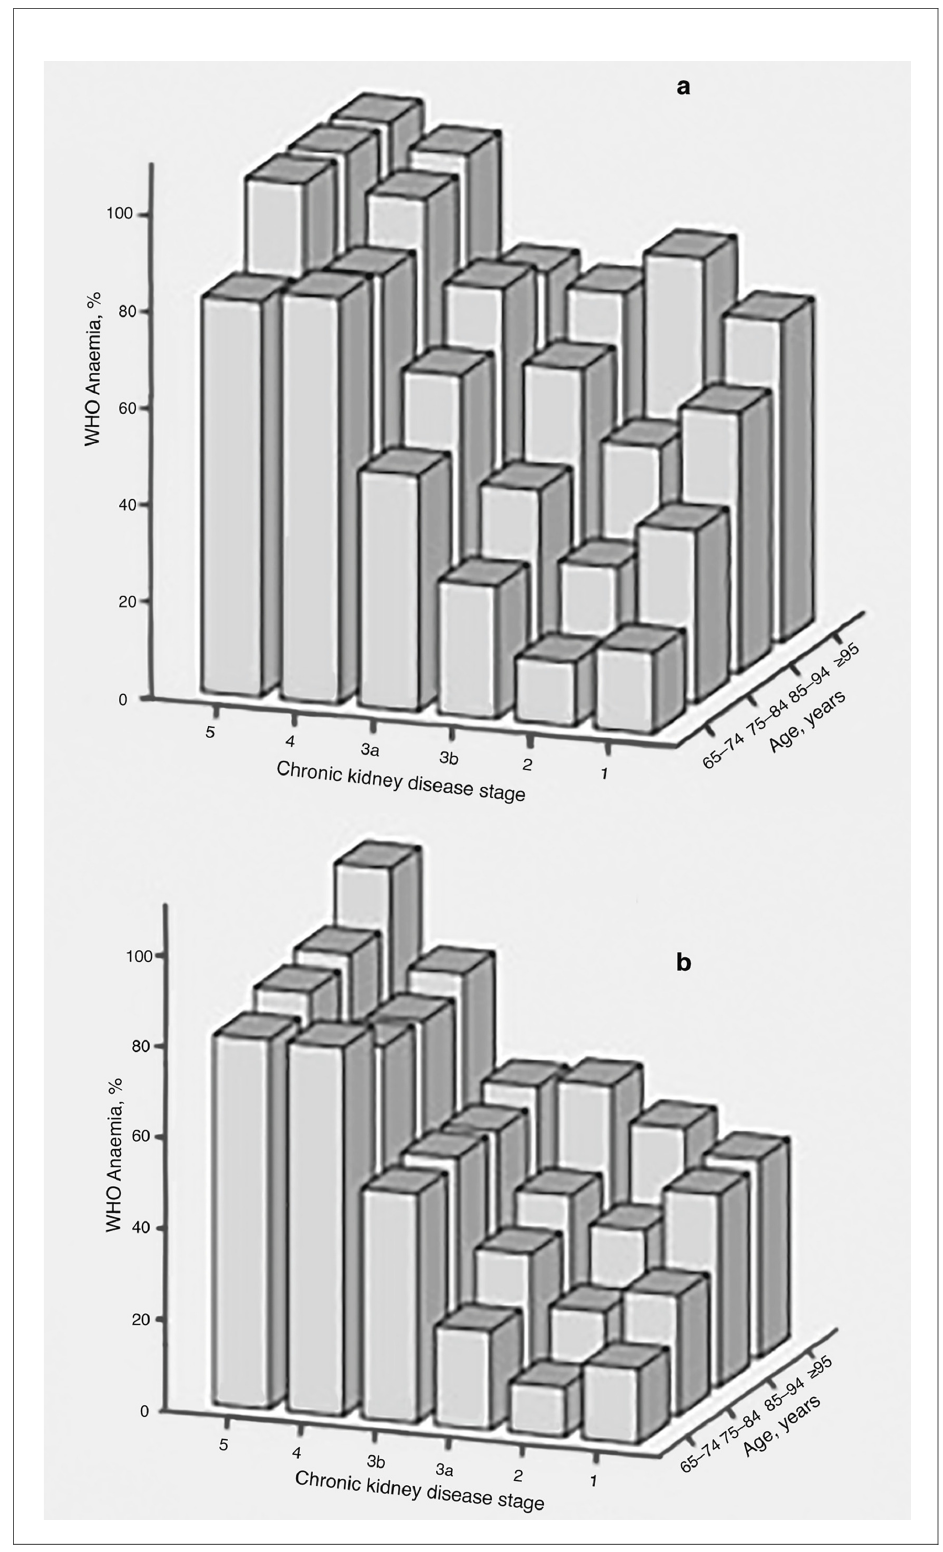
Figure 2. Distribution of anaemia according to age and CKD status in men ( a ) and women ( b